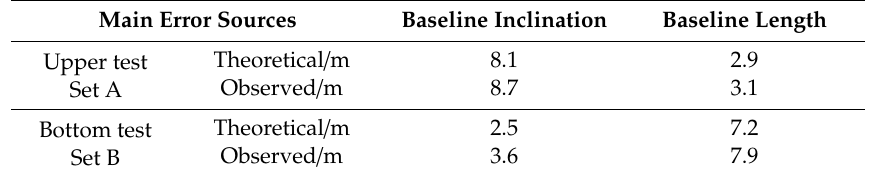
Figure 14. DEM theoretical error distributions by each error source: Slant range (upper left), baseline length (upper right), baseline angle (lower left), in-phase (lower right). Table 2. Comparison between real-data error and theoretical error in different situations.